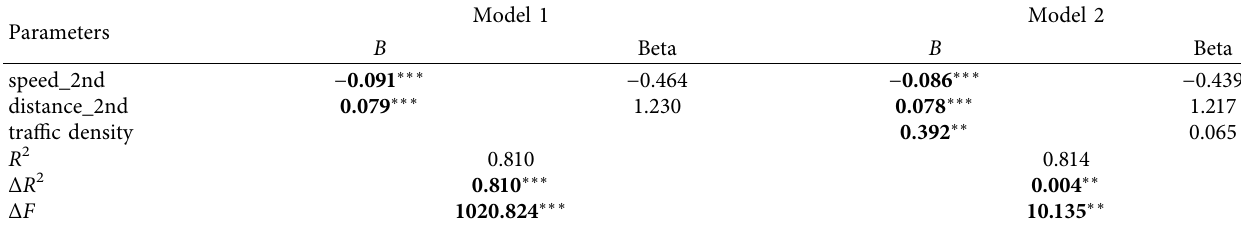
Table 13: Results of the braking duration based on free-driving